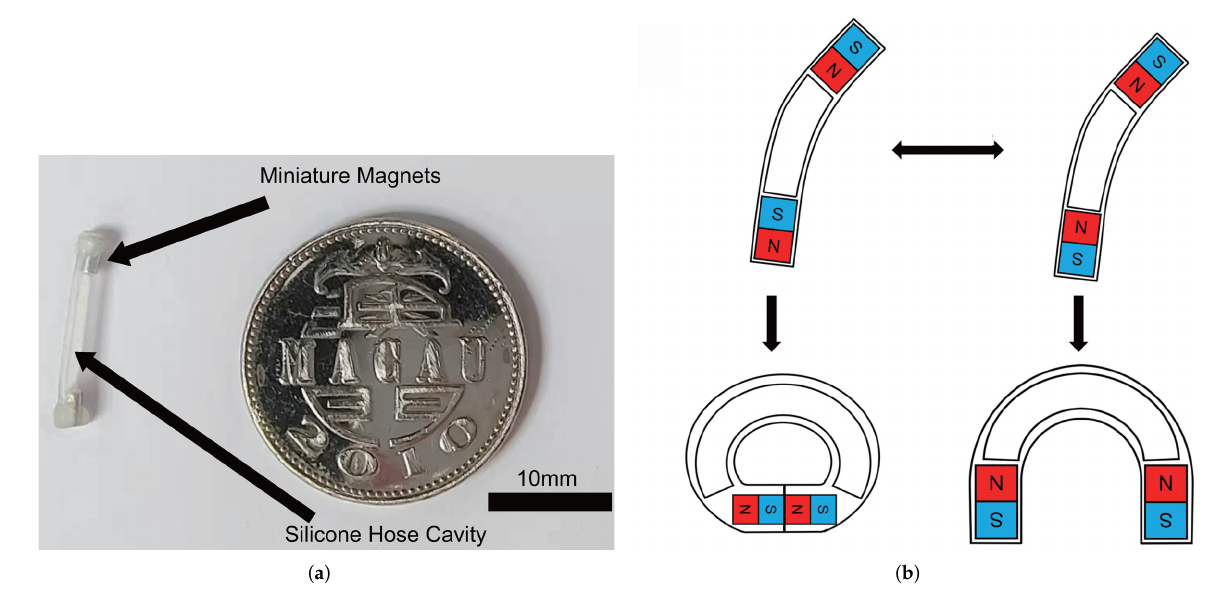
Figure 1. Physical prototype and illustration of the working principle of the MHCMM. ( a ) The main structure of the MHCMM is composed of two miniature magnets at the two terminals and a silicone hose cavity in the middle. ( b ) The magnetism at the end of two magnets can be controlled to perform different functions. When the poles at both ends of the MHCMM are tuned to be the same polarity, an arch shape can be produced by applying an external gradient magnetic field. When they have different polarity magnetic poles, a circumferential shape can be